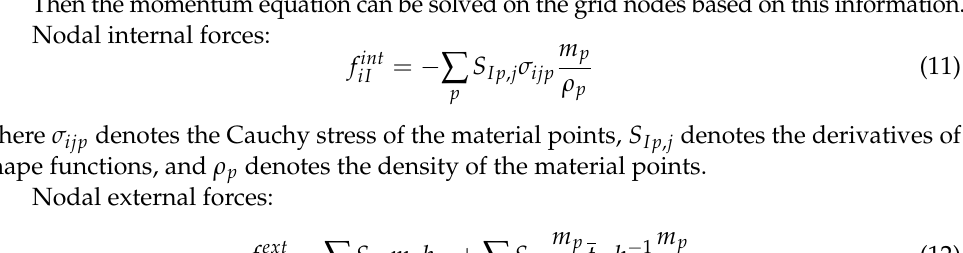
shape functions, and ρ p denotes the density of the material